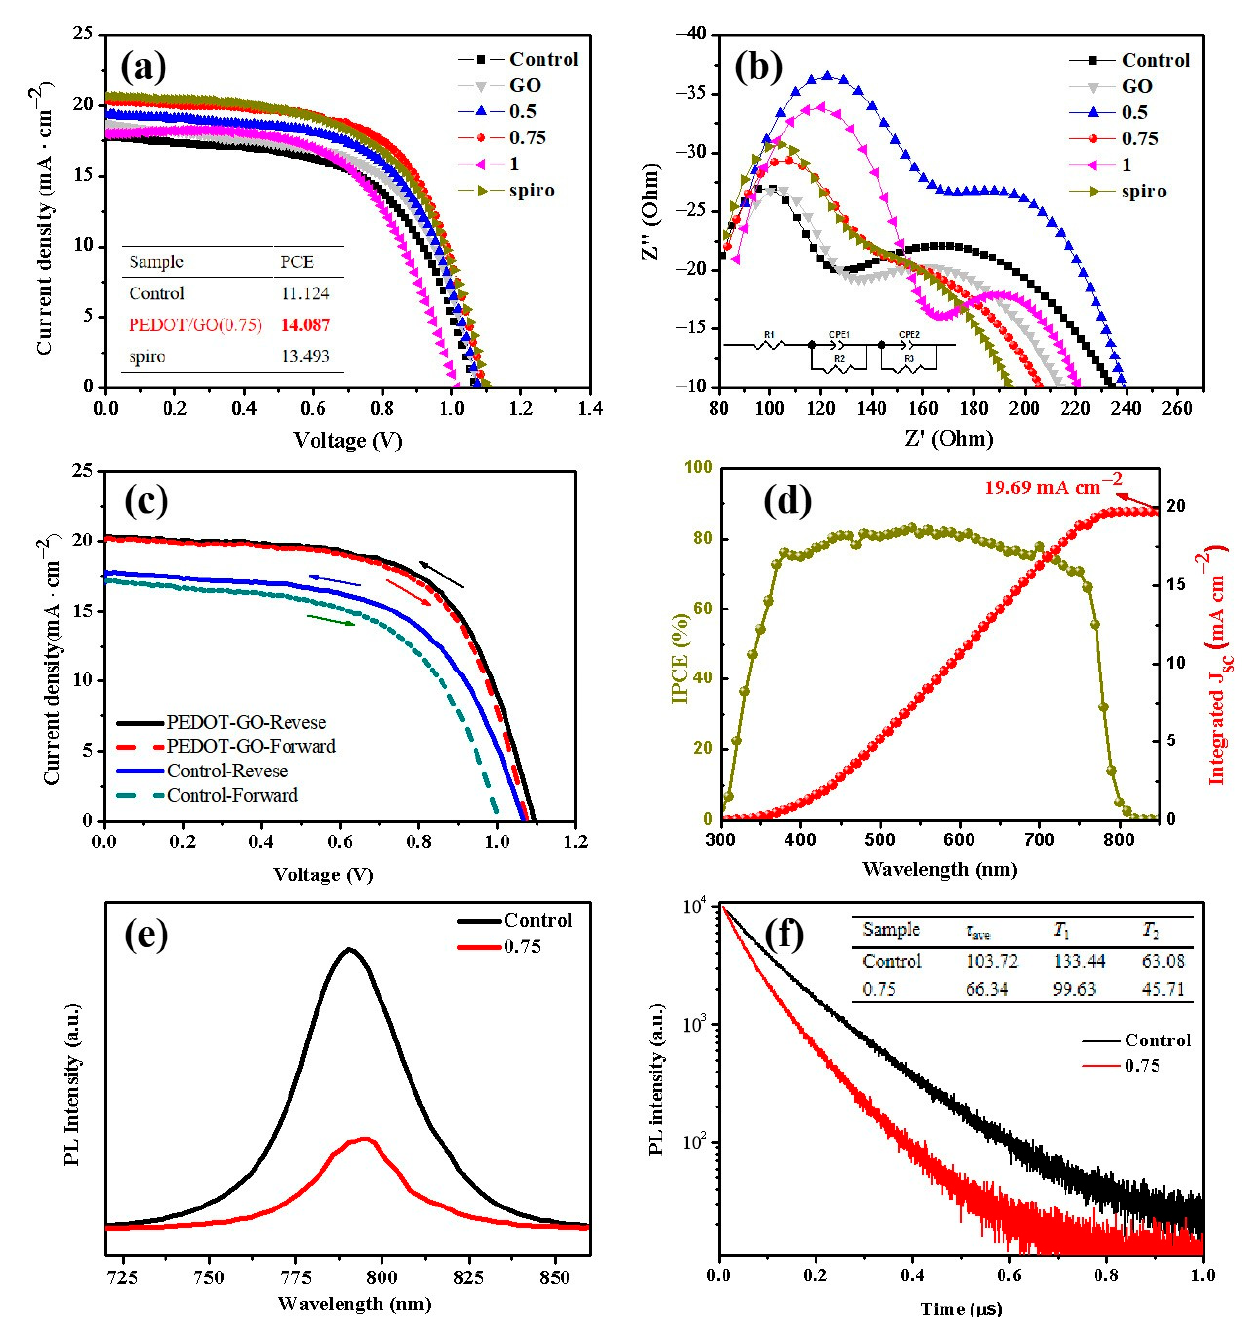
Figure 3. ( a ) J-V curves of control (HTL-free) sample and mass ratio PEDOT/GO: 0/1, 0.5/1, 0.75/1, 1/1, spiro-OMeTAD samples ( b ) Nyquist plots of resistance for the above samples ( c ) current-voltage characteristics with forward and reverse scans of PEDOT-GO and control sample ( d ) IPCE spectra of the PEDOT-GO (0.75) devices ( e ) steady-state PL spectra of PSCs of HTL-free sample and PSCs with PEDOT-GO (0.75) ( f ) time-resolved PL spectra of HTL-free sample and PSCs with PEDOT-GO